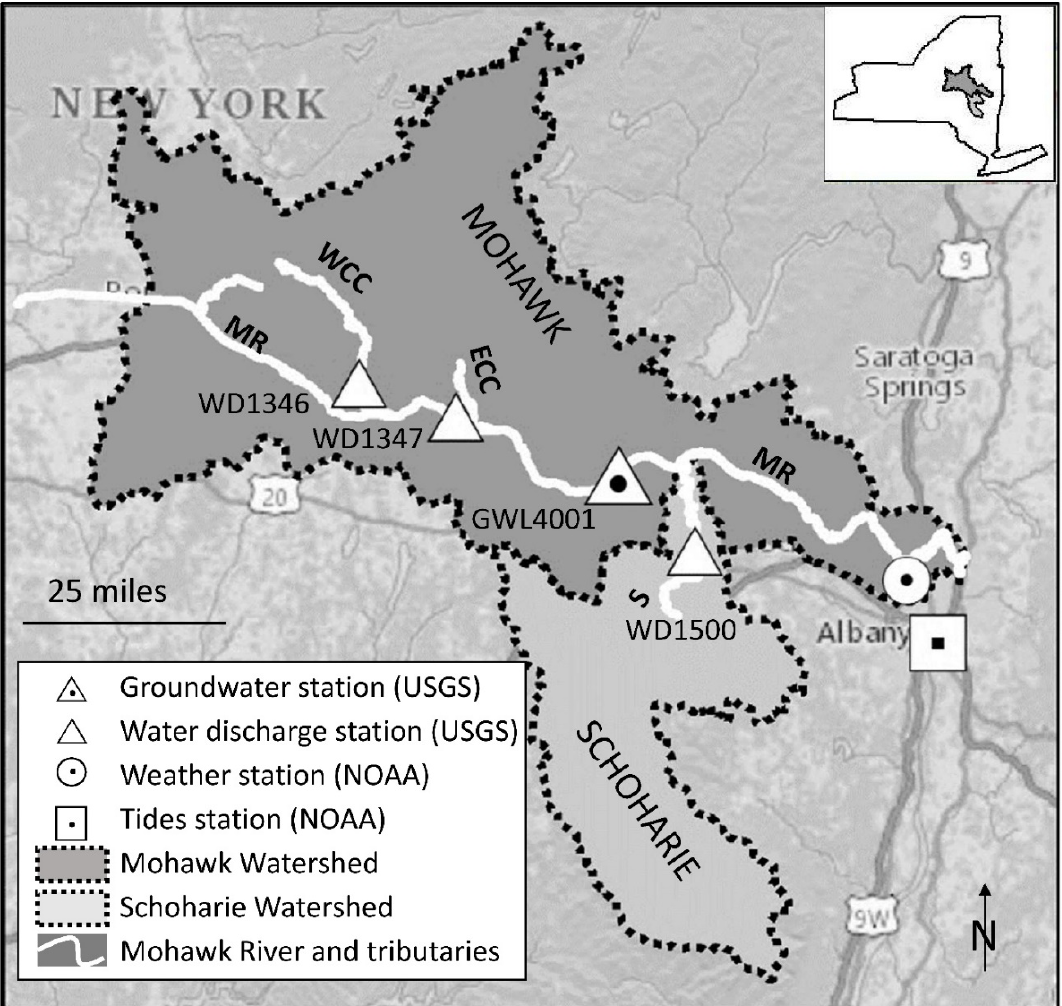
Figure 1. The map shows the location of the weather station, the USGS groundwater station (GWL4001), the two USGS water discharge stations (WD1346 and WD1347) located at the Mohawk River (MR) area of the Mohawk watershed, the third station (WD1500) located at the Schoharie Creek (S) of the Schoharie watershed, and the station of the tides in Albany, NY (ECC—East Canada Creek; MR—Mohawk River; S—Schoharie Creek; WCC—West Canada Creek; NOAA—National Oceanic and Atmospheric Administration; USGS—United States Geological Survey). The geographic information system (GIS) map was composed in ArcMap utilizing data from the New York State clearinghouse and the New York geographic information gateway.